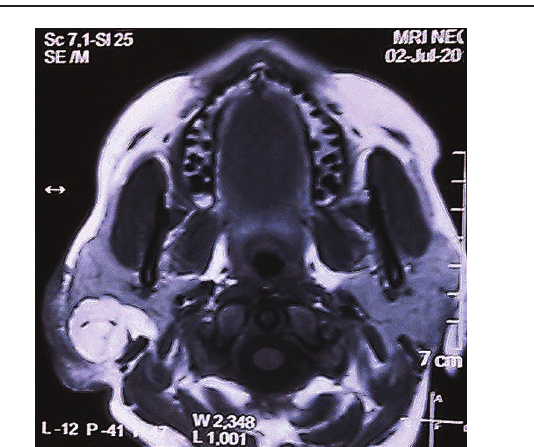
Resected specimen